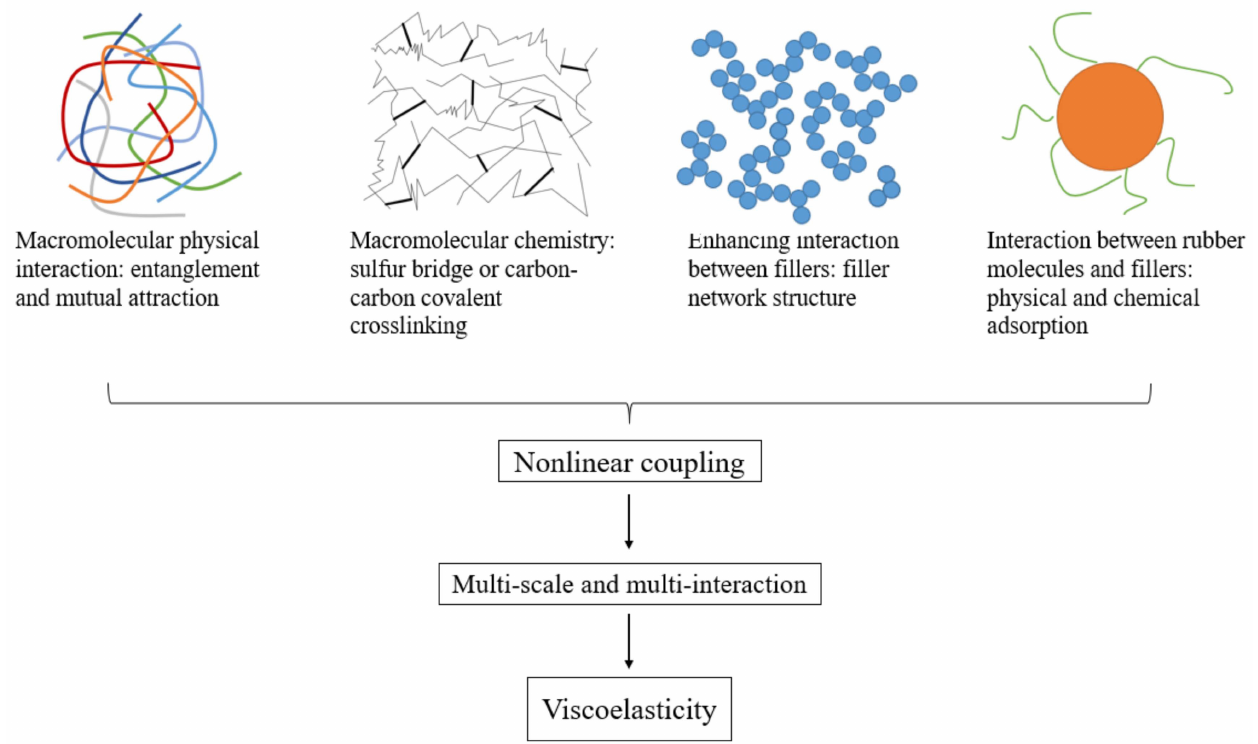
Figure 1. Four main interactions within rubber-based